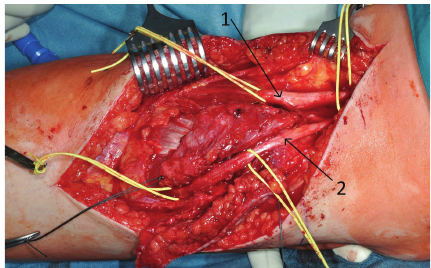
Figure 3: Intraoperative picture: 1 tibial nerve, 2 common peroneal nerves.